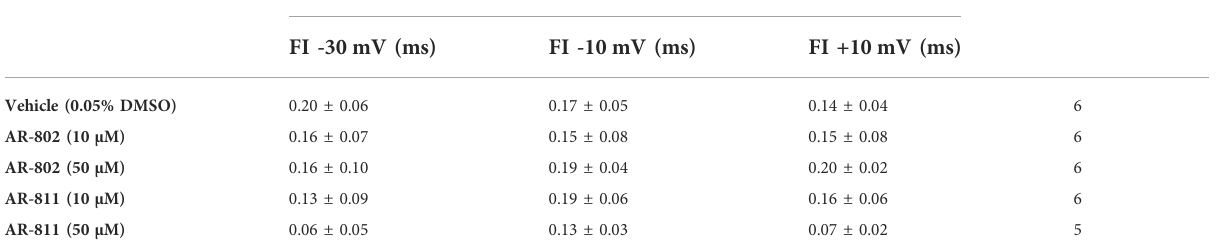
TABLE 8 E1784K FI ONSET from I-V relationship. Difference post — Pre treatment ( Δ